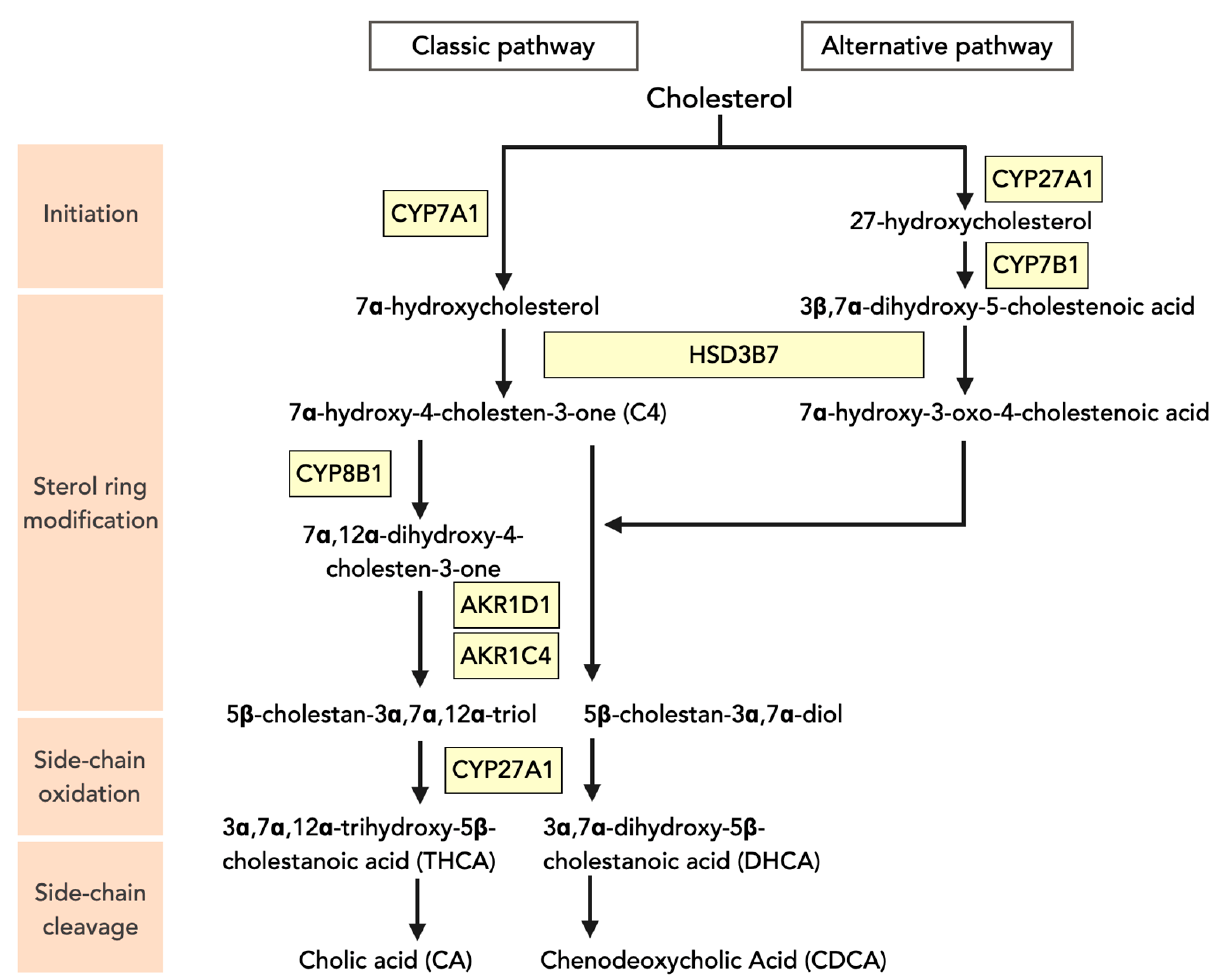
Figure 1. Bile acid synthetic pathways. The conversion of cholesterol into bile acids occurs through two different pathways, i.e., the classical (or neutral) pathway and the alternative (or acidic) path- way, which is quantitatively less important. The classical pathway is initiated by cholesterol 7 α - hydroxylase (encoded by CYP7A1 ) in the endoplasmic reticulum of hepatocytes, and the alterna- tive pathway is initiated by mitochondrial sterol 27-hydroxylase (encoded by CYP27A1 ). In the liver, 3 β -hydroxysteroid dehydrogenase (3 β HSD, HSD3B7) converts 7 α -hydroxycholesterol to 7 α - hydroxy-4-cholesten-3-one (C4), which is used as a surrogate marker of bile acid synthesis. Sterol 12 α -hydroxylase (encoded by CYP8B1 ) introduces a hydroxyl group at the steroid nucleus (at C-12), ultimately leading to the synthesis of cholic acid (CA). Without 12 α -hydroxylation, chenodeoxycholic acid (CDCA) is generated. Aldos-keto reductase 1D1 (AKR1D1) and AKR1C4 catalyse isomerization and saturation of the steroid ring. CYP27A1 then catalyses steroid side-chain oxidation. CA and CDCA represent the two main end-products of the primary bile acid synthesis pathways in the human liver and are conjugated with glycine or taurine before secretion into bile. In the intestine, these primary bile acids are subjected to activities of bacterial bile salt hydrolases and dehydroxylases, generating the various secondary bile acid